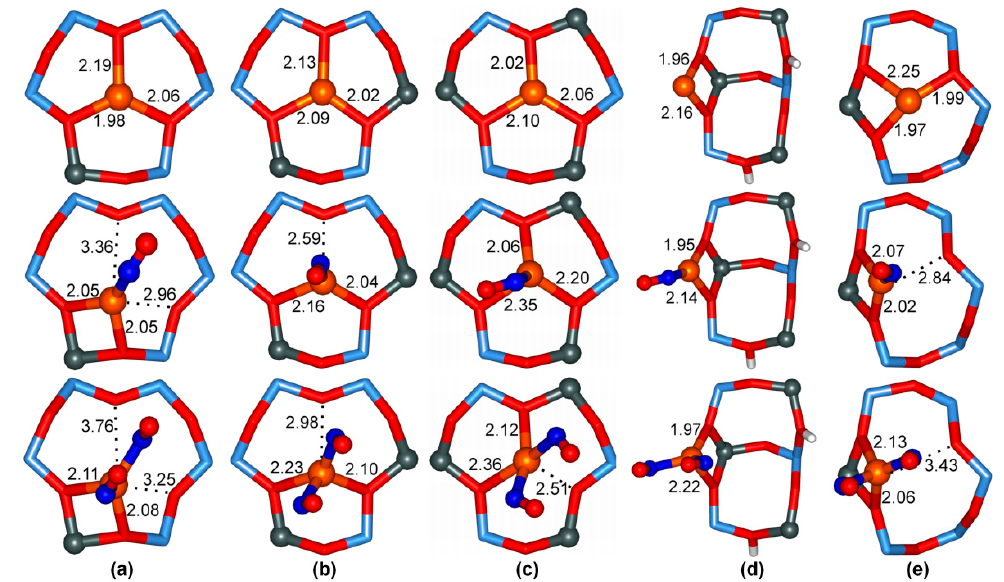
Figure 4. The Cu(I) siting and its change upon adsorption of one and two NO molecules, according to QMPot modeling (only the nearest neighborhood of Cu(I) ions shown, all distances in Å): ( a – c ) site II in FAU with 1, 2 and 3 Al/6T rings, ( d ) site III in FAU and ( e ) Z6 site in MFI. The colors used for the atoms are: Cu—orange, Al—grey, Si—blue, O—red, H—white, N—dark blue.